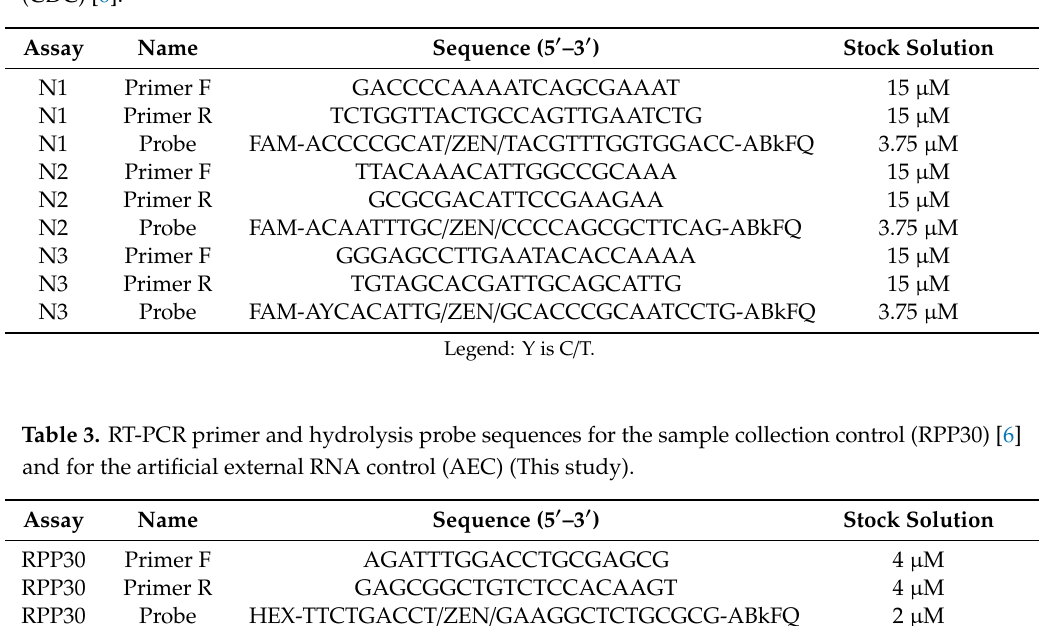
Table 2. RT-PCR primer and hydrolysis probe sequences, according to the Centers for Disease Control (CDC) [6].